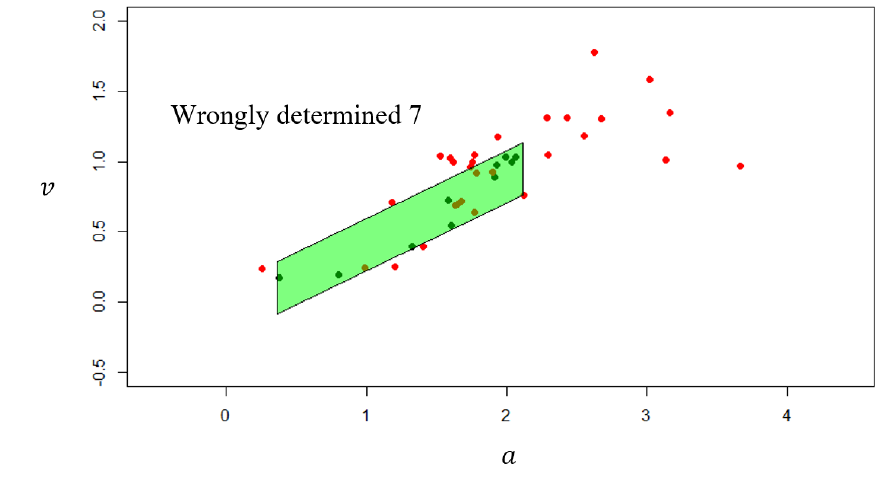
Figure 9. Found positive value